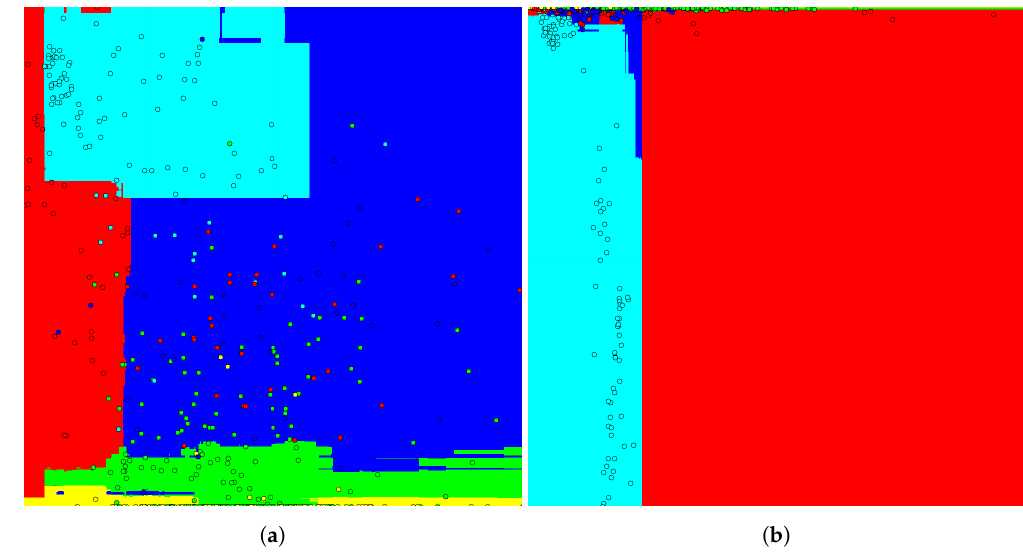
Figure 9. Classification space of the Random Tree Classifier to ( a ) the worst 2D feature combination ( Inertia Ratio (3) with Convexity (8)) and ( b ) the best 2D feature combination ( Mean Intensity (5) with Convex Hull Area (7)).